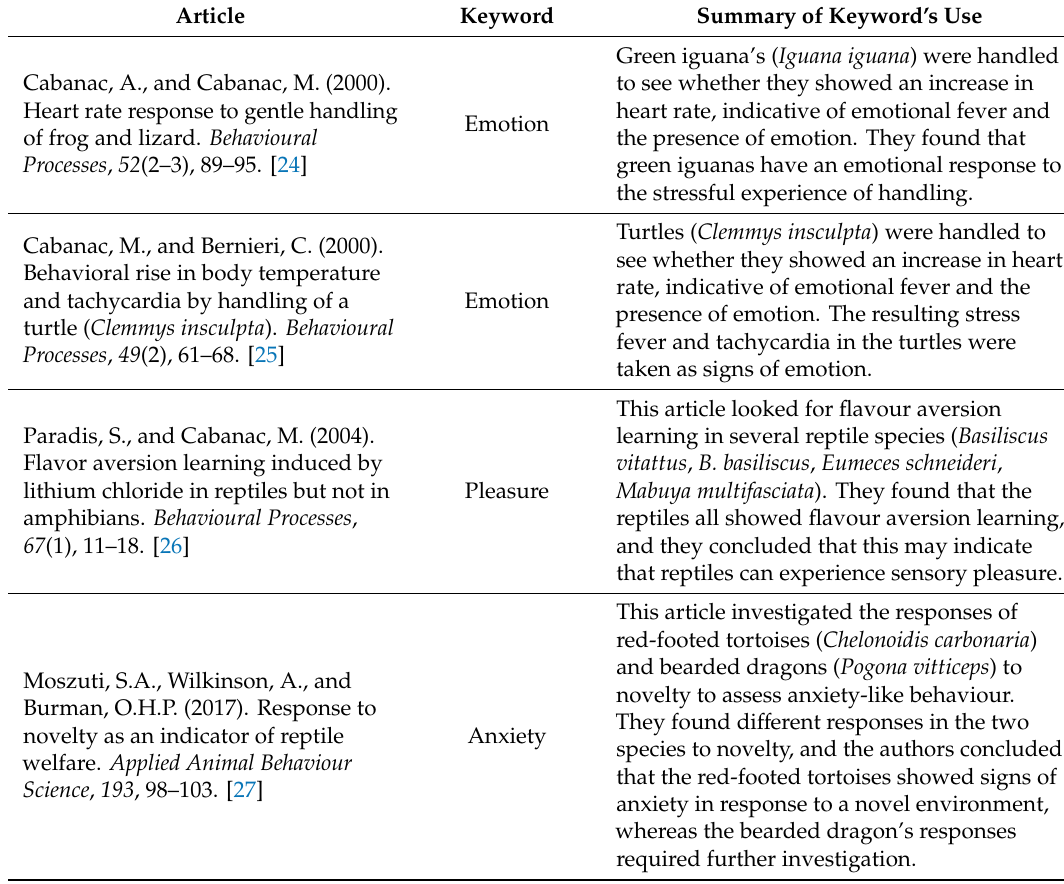
Table 1. The articles found to explore sentience in reptiles, and a summary of the related